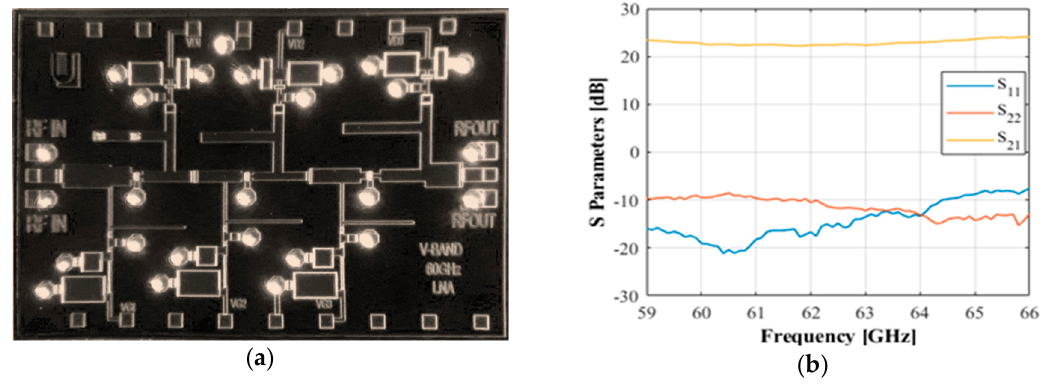
Figure 10. Realized V-band LNA monolithic microwave integrated circuit (MMIC). ( a ) Micro- photograph, chip size is (3.0 × 2.0) mm 2 and ( b ) measured S-parameters in the 59 − 66 GHz bandwidth.